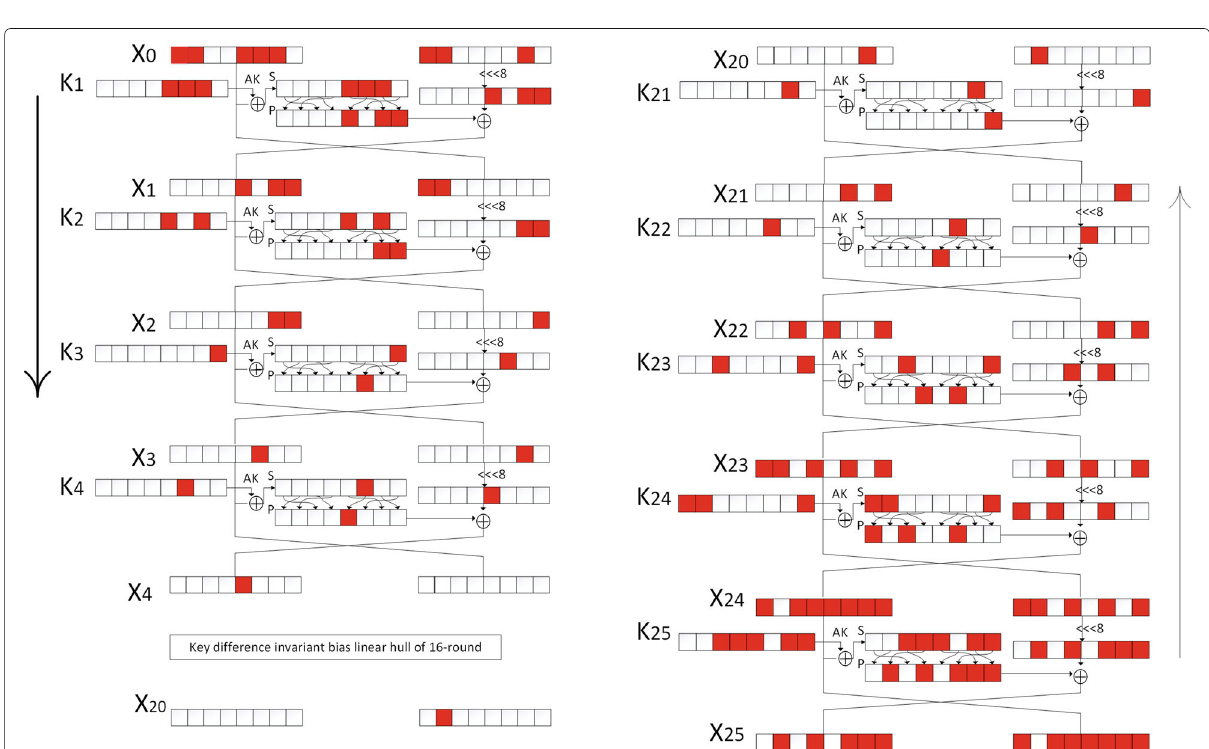
Fig. 2 Attack on 25-round